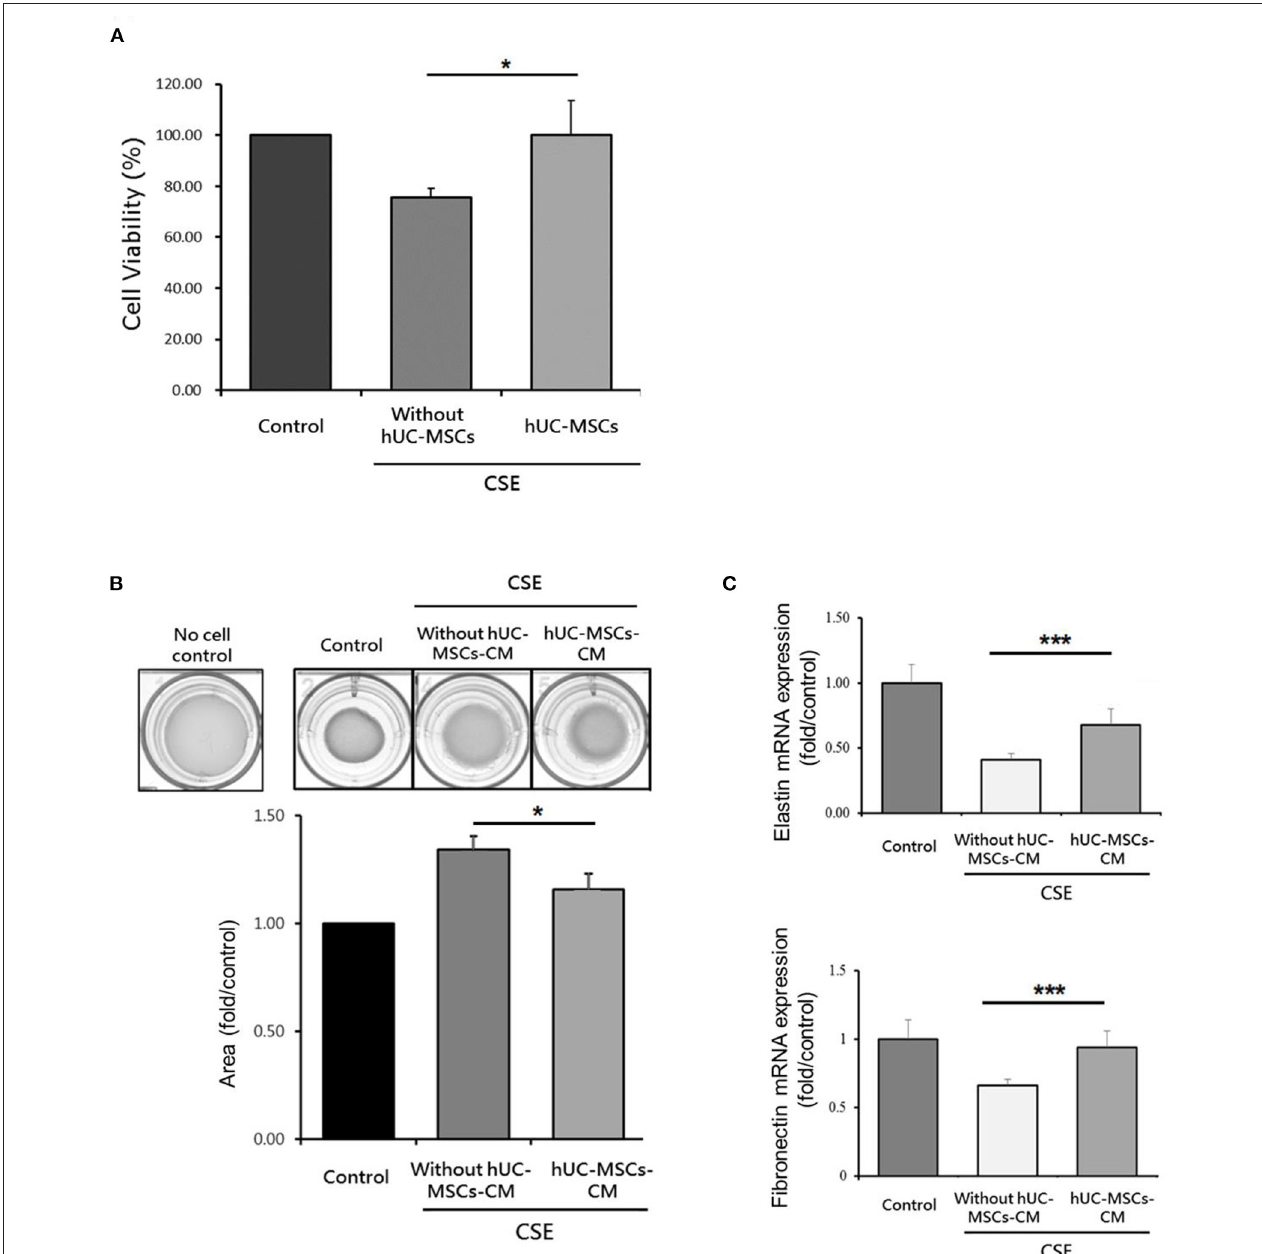
FIGURE 5 | (A) Increased cell viability of human lung fibroblasts by human umbilical cord-derived mesenchymal stem cells (hUC-MSCs) after cigarette smoke extract (CSE) exposure. (B) Restoration of the contractile force of lung fibroblasts by hUC-MSCs-conditioned medium (hUC-MSCs-CM). (C) hUC-MSCs-CM increased mRNA expressions of elastin and fibronectin in lung fibroblasts after CSE treatment. A transwell coculture system was used to determine cell viability of human lung fibroblasts (MRC5 cell line). A significant increase in cell viability (%) of MRC5 cells by hUC-MSCs was observed after CSE treatment for 24h. MRC-5 cells were treated by CSE for 24h and then received hUC-MSCs-CM for 24h afterward. The contractile force was evaluated by a collagen-based cell contraction assay. The mRNA expressions of elastin and fibronectin were quantified by a qPCR. Results were examined by an unpaired t -test. Four independent experiments in each group. * p < 0.05, *** p <